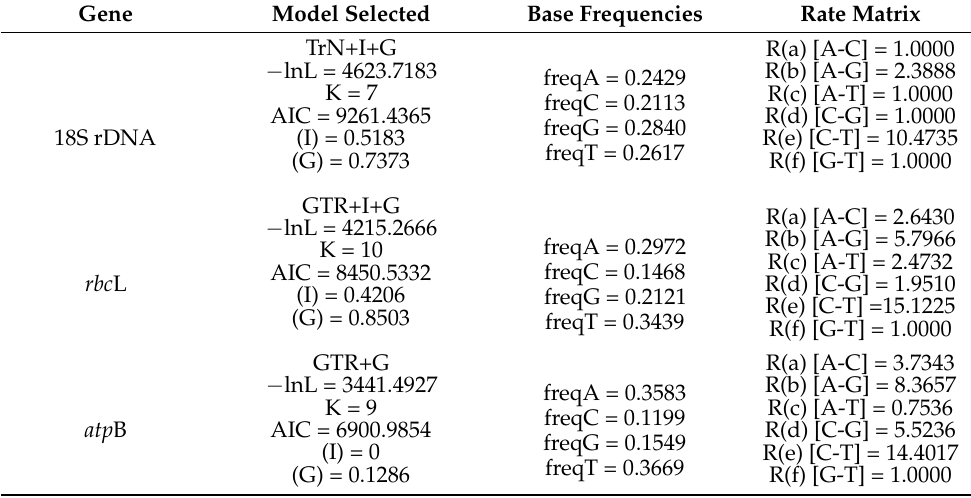
Table 3. Nucleotide substitution model parameter estimates for Modeltest 3.7 analyses.